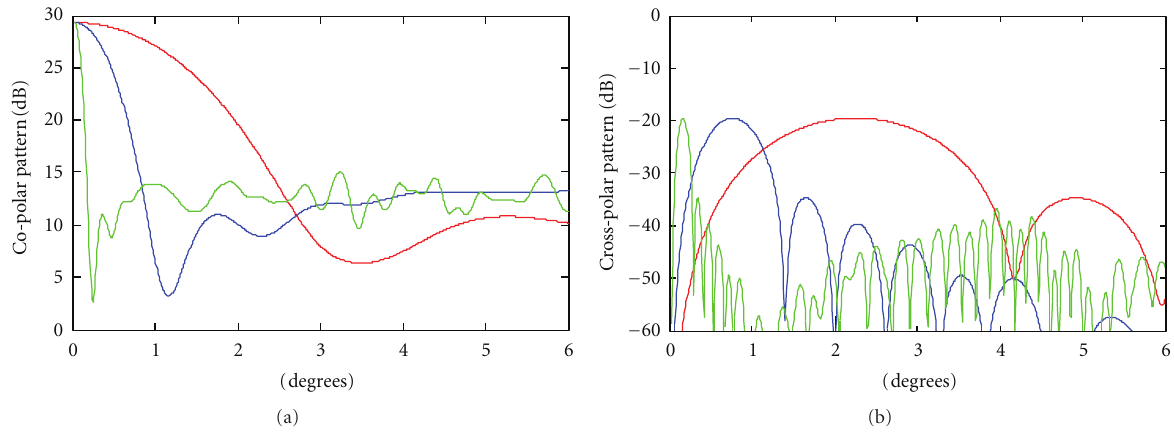
Figure 6: Radiation characteristics of FZPA-M-10 versus angle θ : (a) copolar radiation patterns, (b) cross-polar radiation patterns. Red, blue, and green lines correspond to 90, 270, and 1350 GHz,